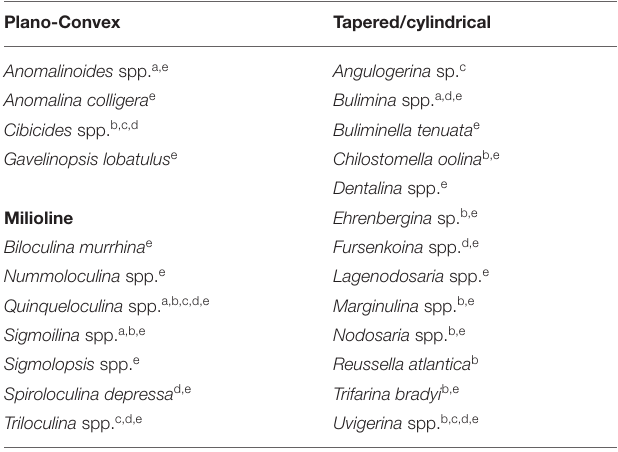
TABLE 2 | Morphotype classification of benthic foraminifera from the examined core SK 218/1.